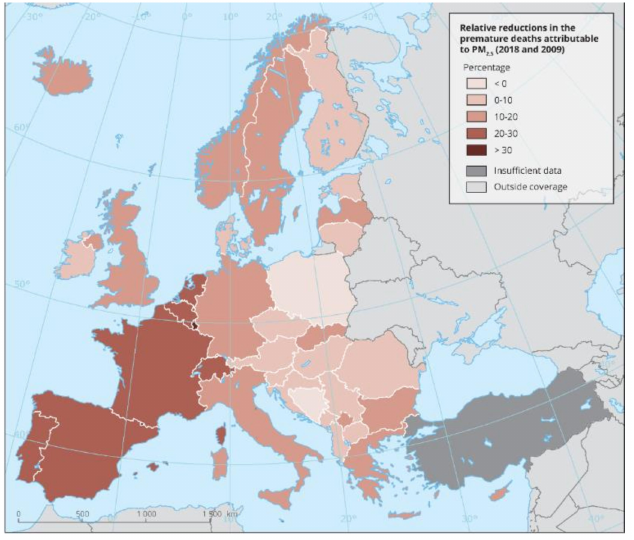
Figure 2. Relative PM 2.5 reductions in the premature deaths (2018 and 2009)